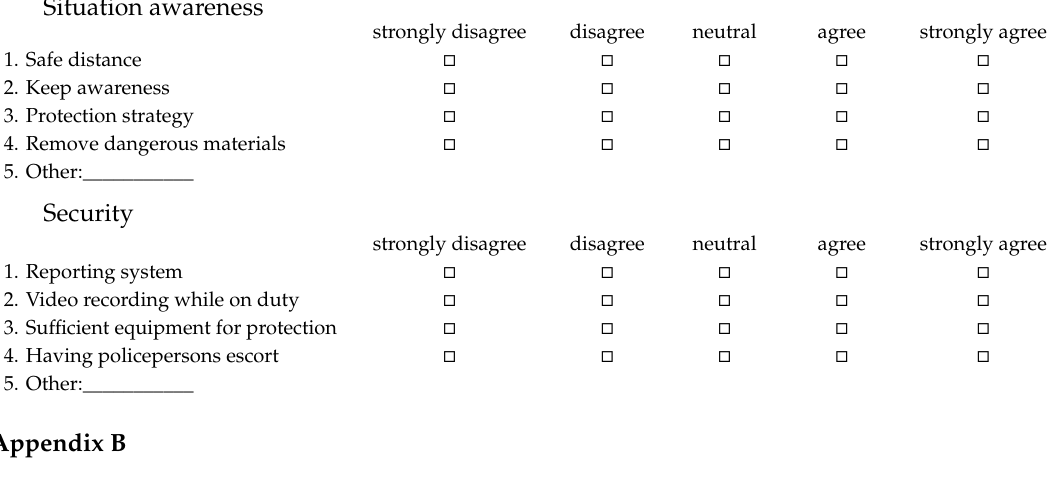
Table A1. Bivariate analysis of reporting to the superiors when emergency medical technicians encounter verbal (N = 113) or physical (N = 75) violence at work.